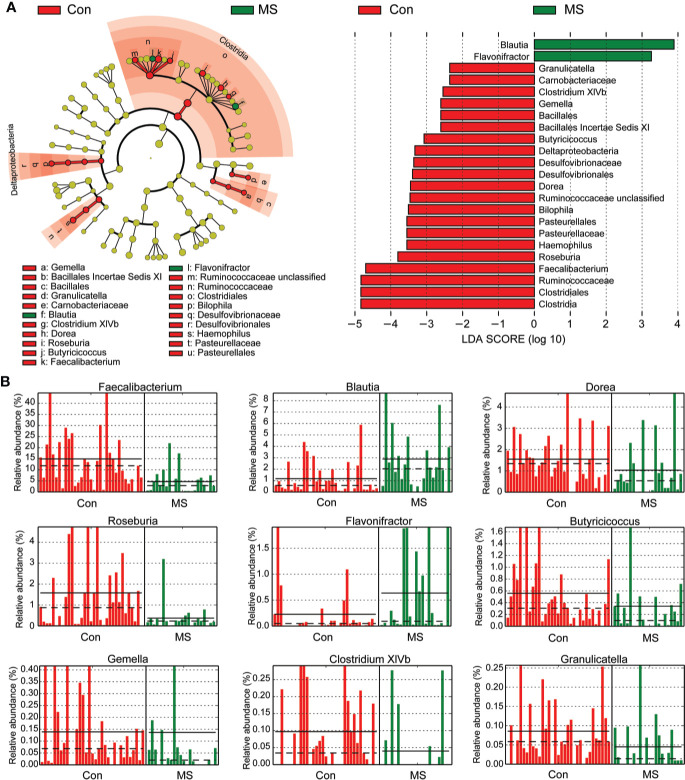
Different bacterial taxa between Chinese patients with multiple sclerosis (MS) and healthy controls. LEfSe identifies the taxa with the greatest differences in abundances between Chinese patients with MS and healthy controls. Only the taxa that meet a significant LDA threshold value of > 2 are shown (A). Nine differentially abundant bacterial taxa were identified between the two groups (B).